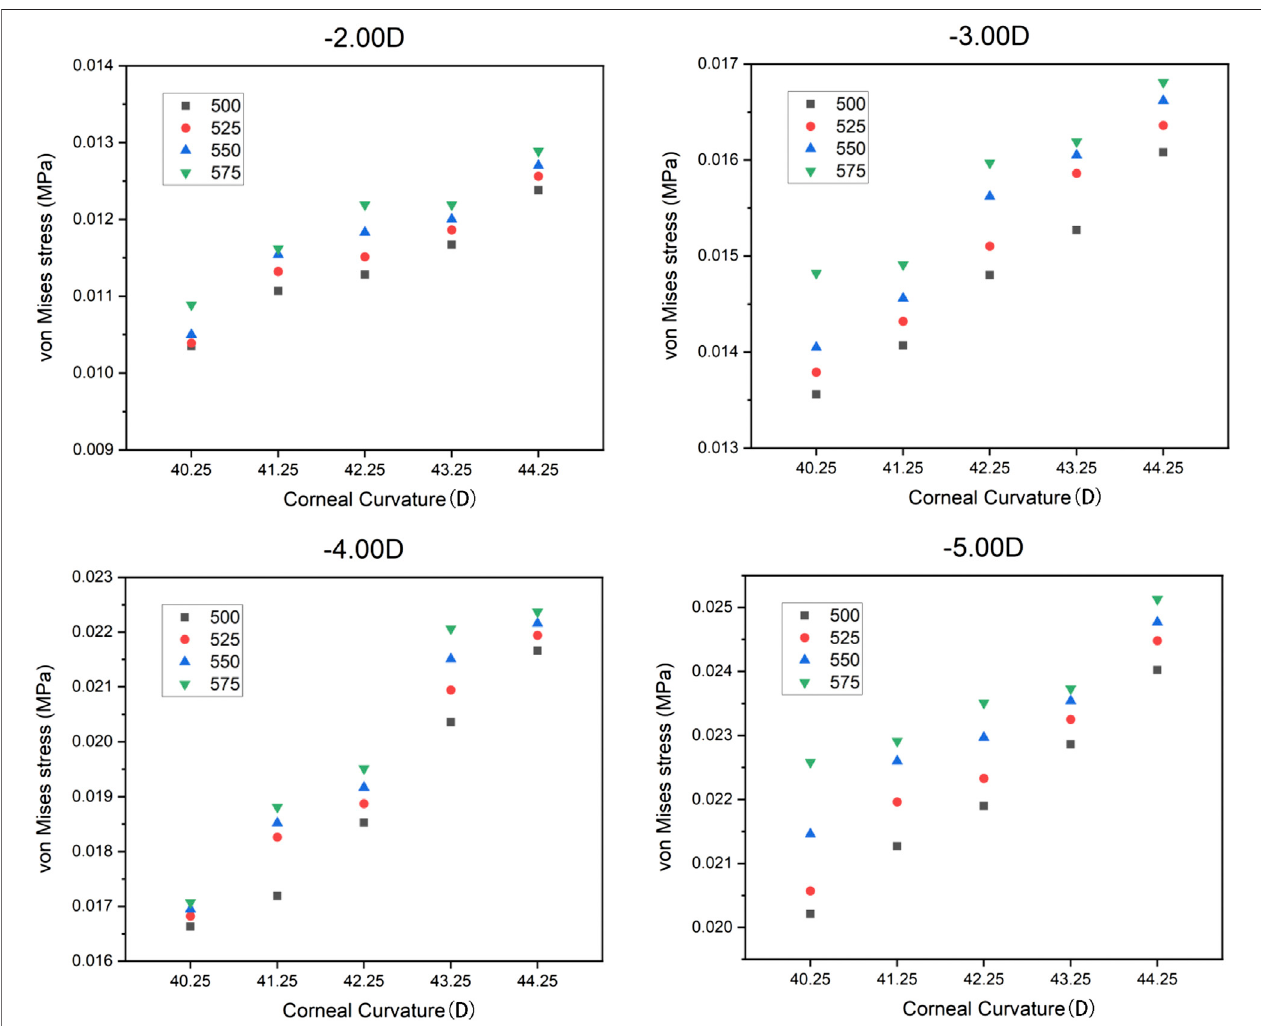
FIGURE 4 | Representative maximum von Mises stress in the central corneal